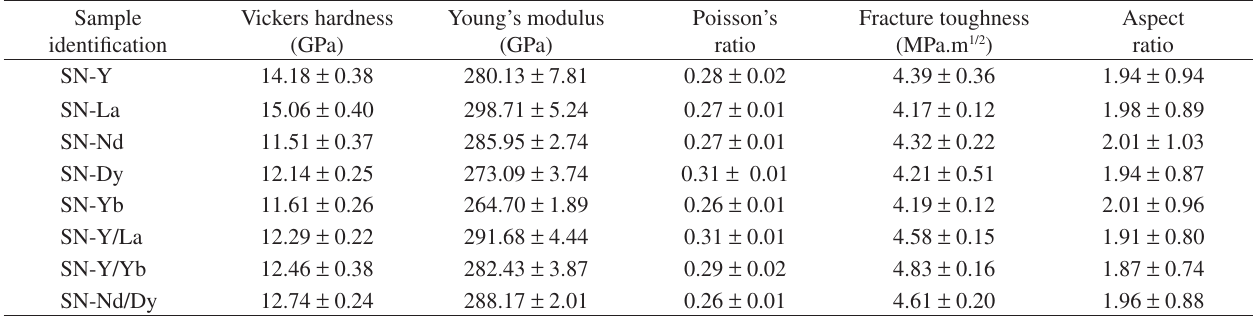
Table 3. Mechanical properties and aspect ratio of the silicon nitride-based ceramics.